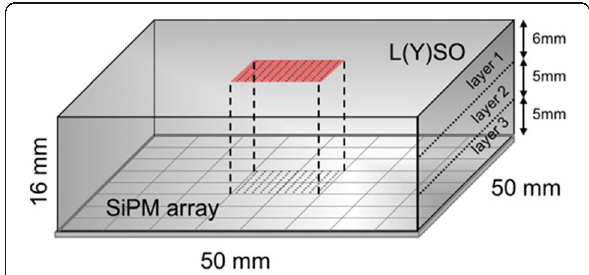
Fig. 1 (abstract A10). The detector is calibrated in a central area of 10x10mm at 11x11 positions